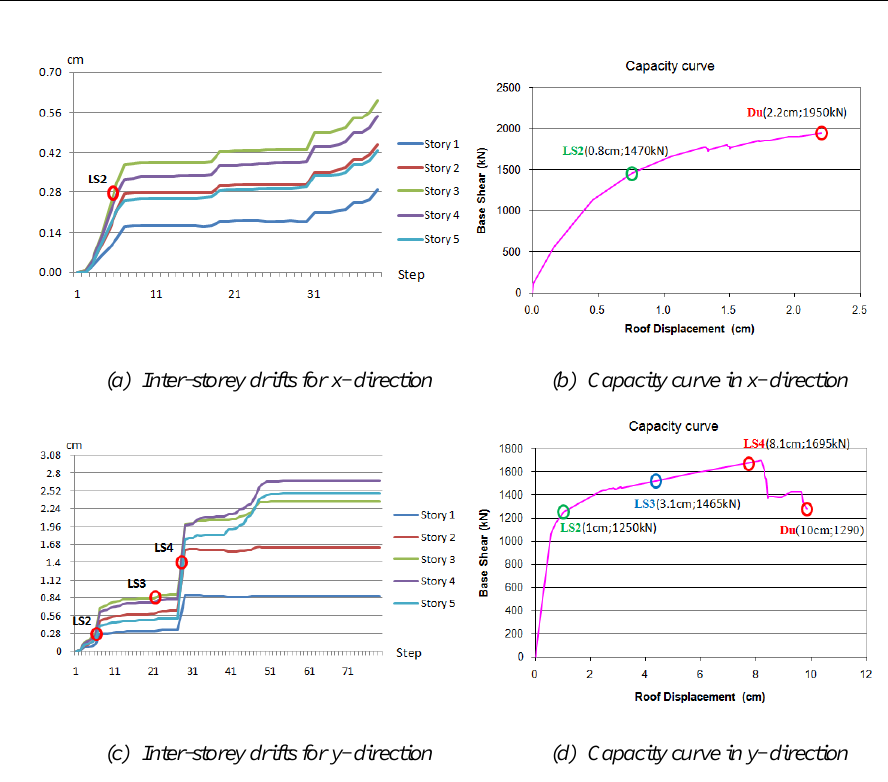
Fig. 8. Inter-storey drift ratios and capacity curve representation of the TD-83/3 obtained by pushover analysis